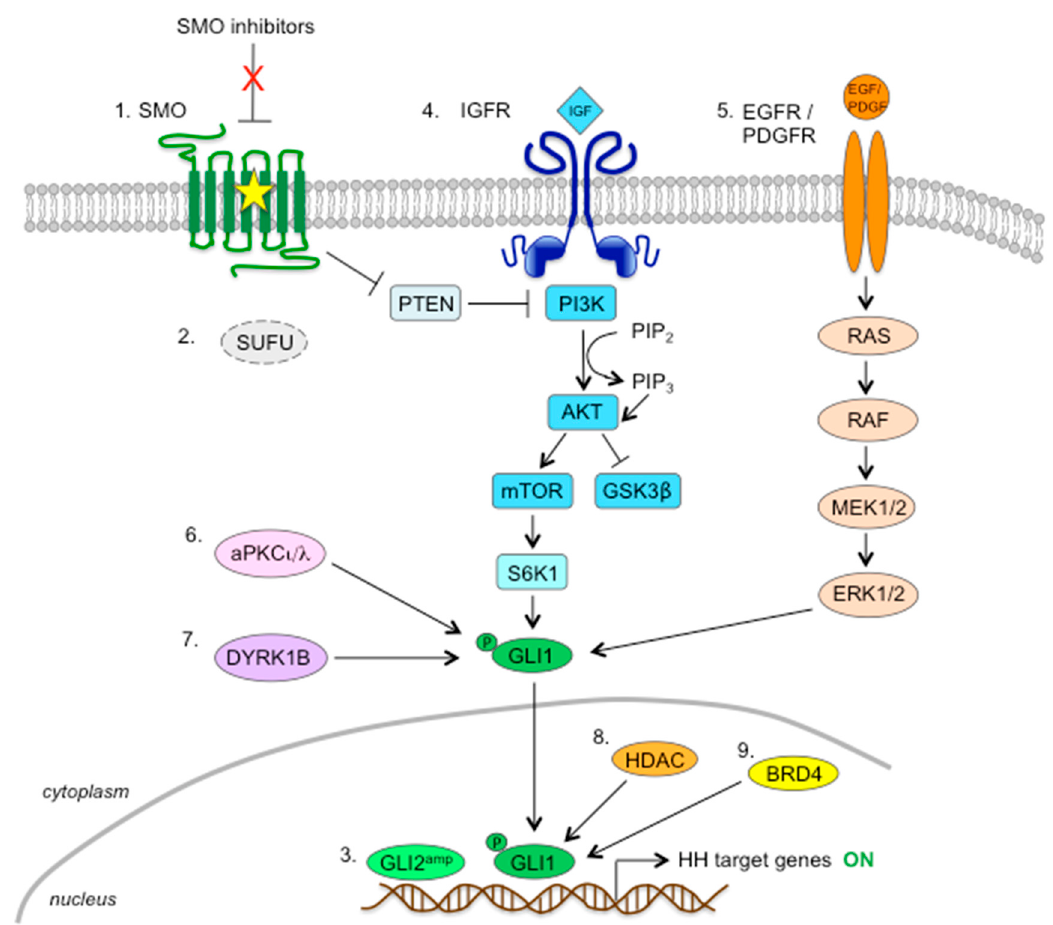
Figure 5. Schematic representation of the mechanisms of resistance to SMO inhibitors. These are represented by: activating mutations in SMO (1); loss of SUFU (2); amplification of GLI2 gene (3); activation of the PI3K/AKT/mTOR pathway, which induces S6K1-dependent phosphorylation and activation of GLI1 (4); activation of the RAS/RAF/MEK/ERK pathway (5); phosphorylation- dependent activation of GLI1 by aPKC ι / λ (6) or DYRK1B (7); histone deacetylases (8); BRD4 protein (9). SMO, Smoothened; SUFU, Suppressor of Fused; IGFR, Insulin growth factor receptor; PTEN, Phosphatase and tensin homolog; PI3K, Phosphatidylinositol-4,5-bisphosphate 3-kinase; mTOR, mammalian target of Rapamycin; GSK3 β , Glycogen synthase kinase 3 β ; S6K1, Ribosomal protein S6 kinase beta-1; EGFR, Epidermal growth factor receptor; PDGFR, Platelet-derived growth factor receptor; MEK1/2, MAP (Mitogen-activated protein) Kinase/ERK (Extracellular signal-Regulated Kinase) Kinase 1; HDAC, Histone deacetylase; BRD4, Bromodomain-containing protein 4.